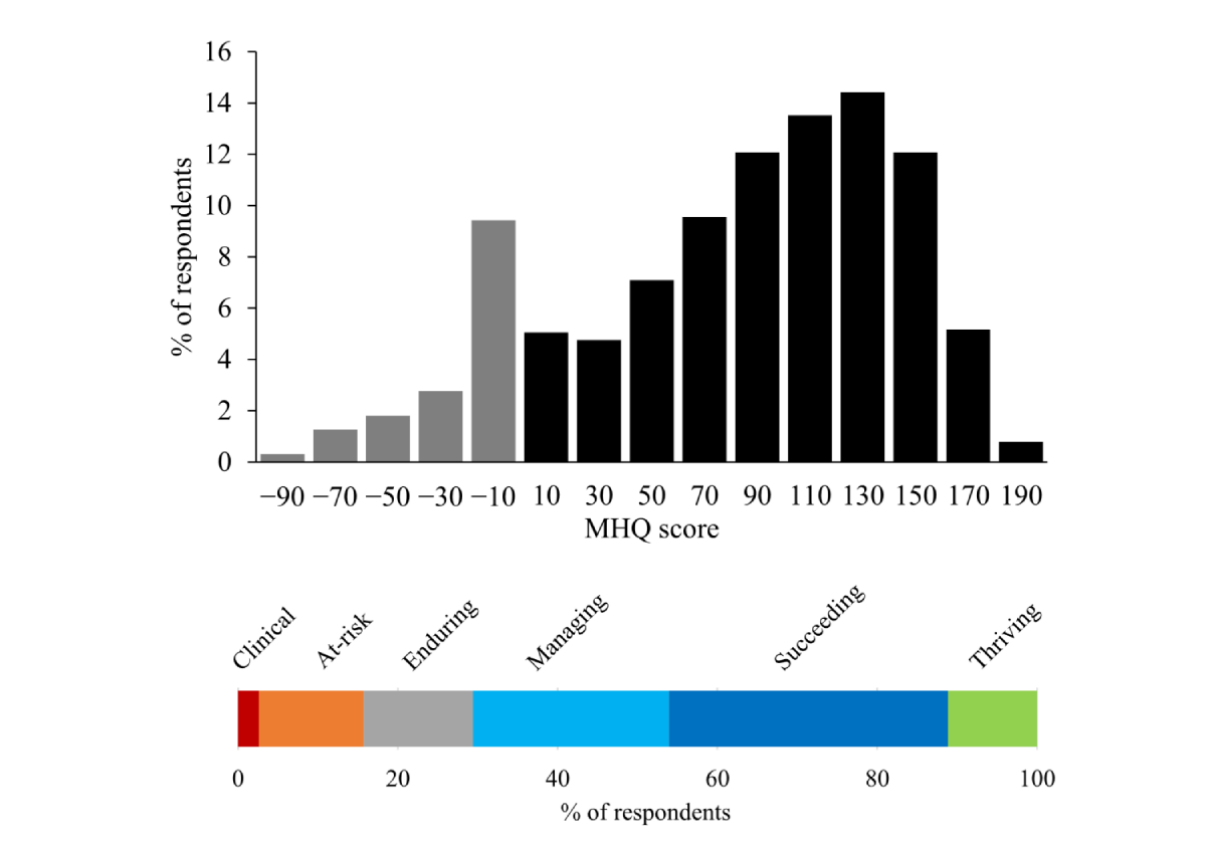
Figure 4. Distribution of Mental Health Quotient scores across 1665 respondents. Shows the percentage of respondents falling into Mental Health Quotient score windows ranging from −100 to +200 and across each of the 6 MHQ score levels. Gray bars denote negative scores and black bars denote positive scores. MHQ score levels are (from left to right) clinical (score range: −100 to −51), at-risk (−50 to −1), enduring (0-50), managing (51-100), succeeding (101-150), and thriving (151-200). MHQ: Mental Health Quotient.